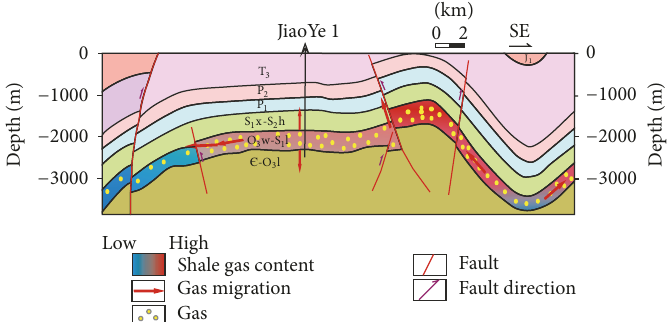
Figure 7: Shale gas accumulation diagram of the Jiaoshiba Area, Southeast Chongqing. See Figure 1 for the location.